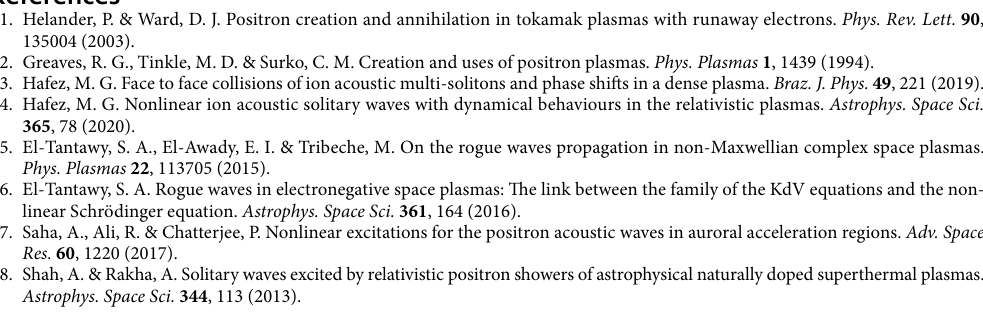
Data sharing is not applicable to this article as no new data were created or analyzed in this study.